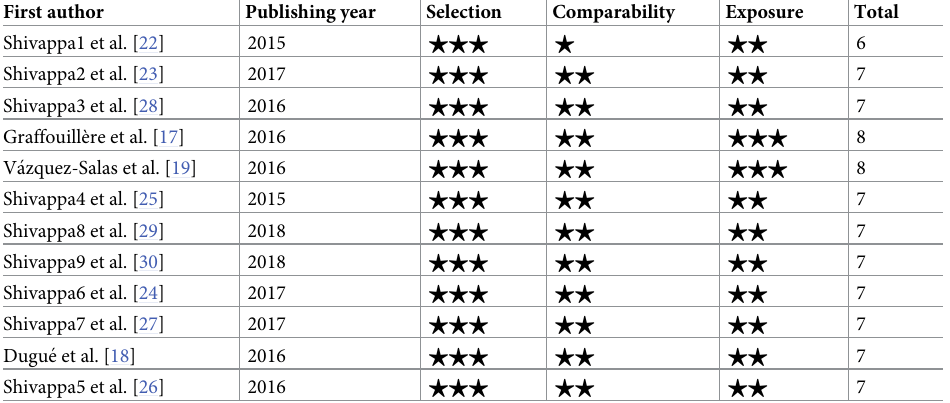
Table 2. Quality assessment of all included studies.